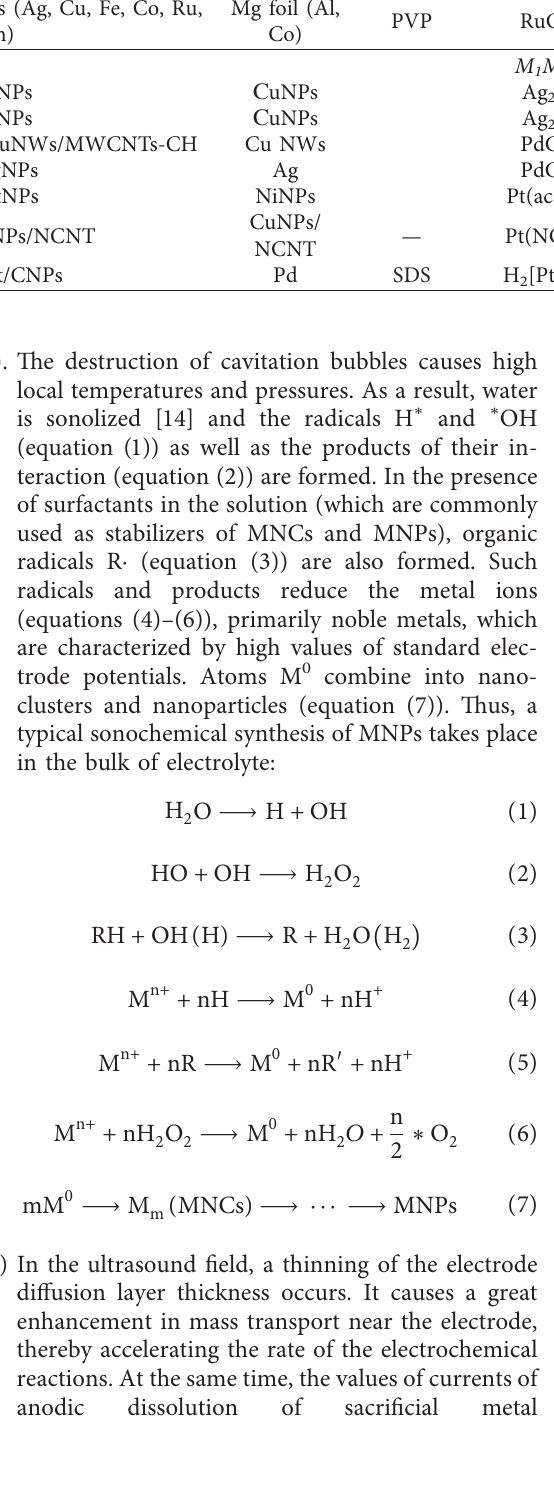
Table 3: Conditions of the synthesis of metallic nanoparticles (MNPs, N